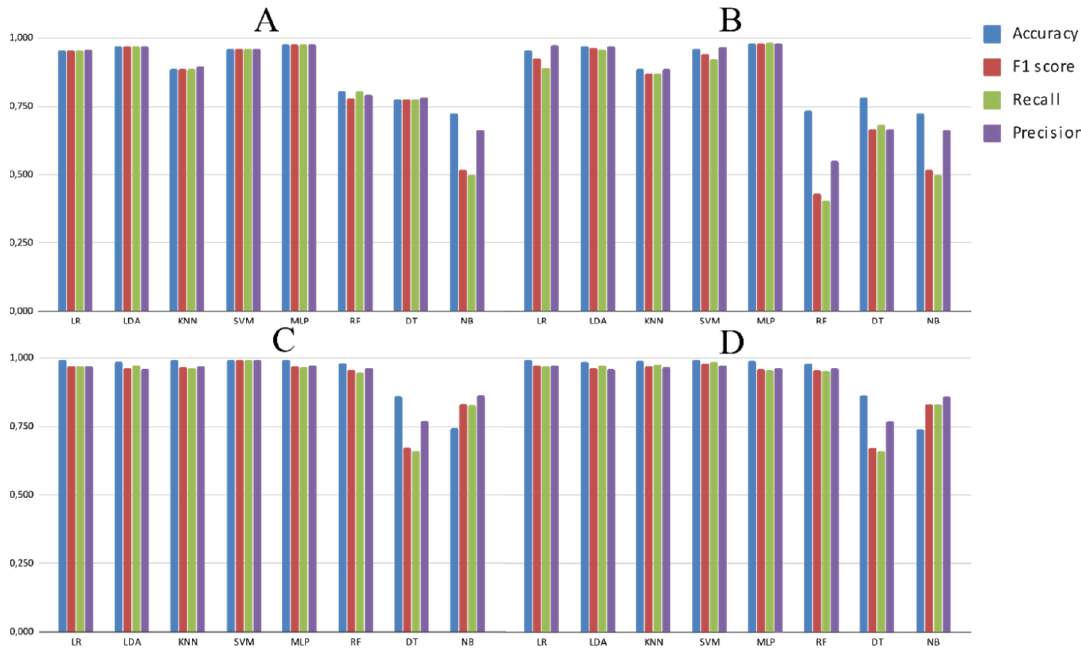
Figure 4. Results of ML algorithms using nucleotide sequences transformed by k-mers, PCA and scaling, and applying accuracy, F1-score, recall and precision metrics. Experiments: ( A ) Exp1, ( B ) Exp2, ( C ) Exp3, and ( D ) Exp4.